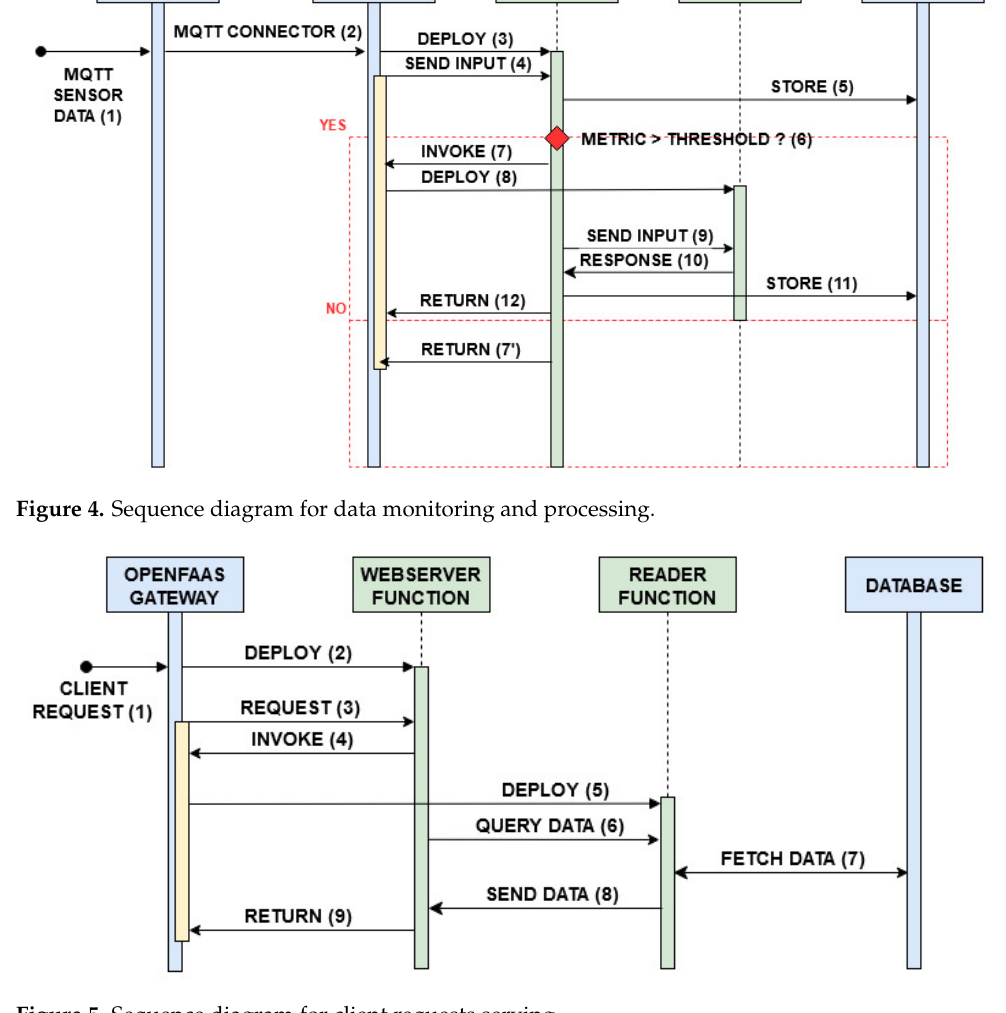
Figure 5. Sequence diagram for client requests